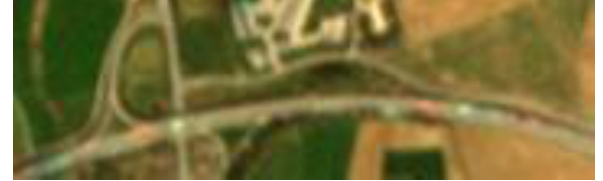
Figure 10: Profiles along the green lines from fig. 9, left: truck (also left in image), right: two cars, all travelling from left to right, DN vs. metres